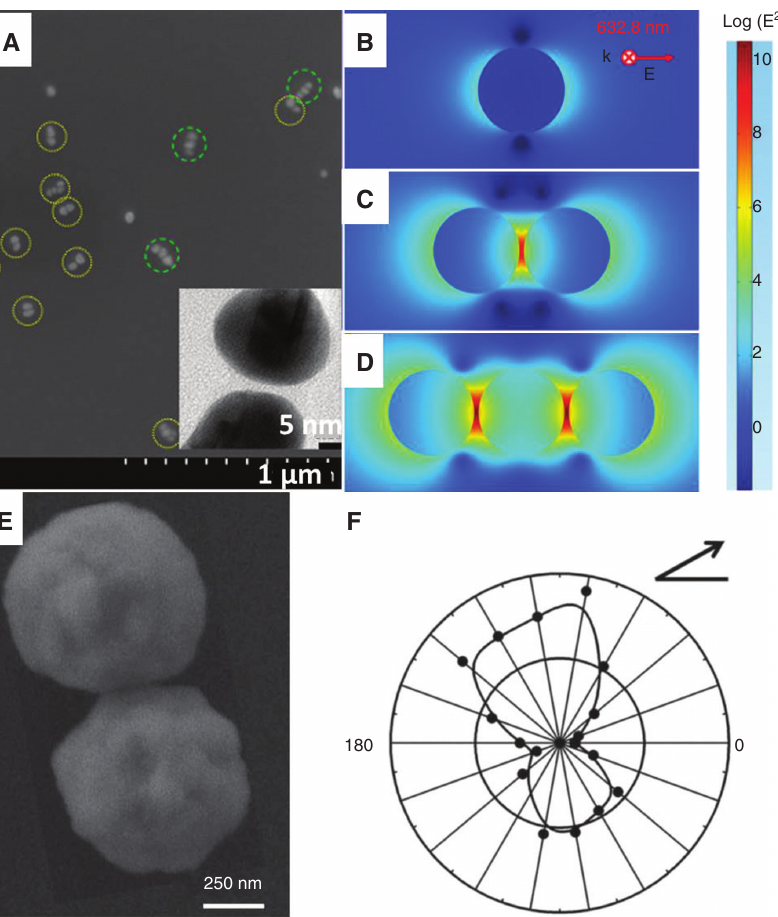
Figure 3: (A) SEM image of gold NPs [58]. Dimers and trimers are highlighted by yellow and green circles, respectively. Inset: TEM image of the nanogap between two NPs. (B–D) Images of the simulated distributions of |E| 2 in logarithmic scale with 632.8 nm excitation for single gold NP, dimer, and trimer [58]. (E) SEM image of a dimer consisting of two flower-like silver particles [59]. The dimer axis is rotated about 120 ° with respect to a horizontal line. (F) Polar plot of the Raman intensity as a function of incident polarization [59]. Reproduced with permission from Refs. [58] and [59]. Copyright 2013 AIP Publishing LLC (Ref. [58]), and Copyright 2012 WILEY-VCH Verlag GmbH & Co. KGaA, Weinheim (Ref.